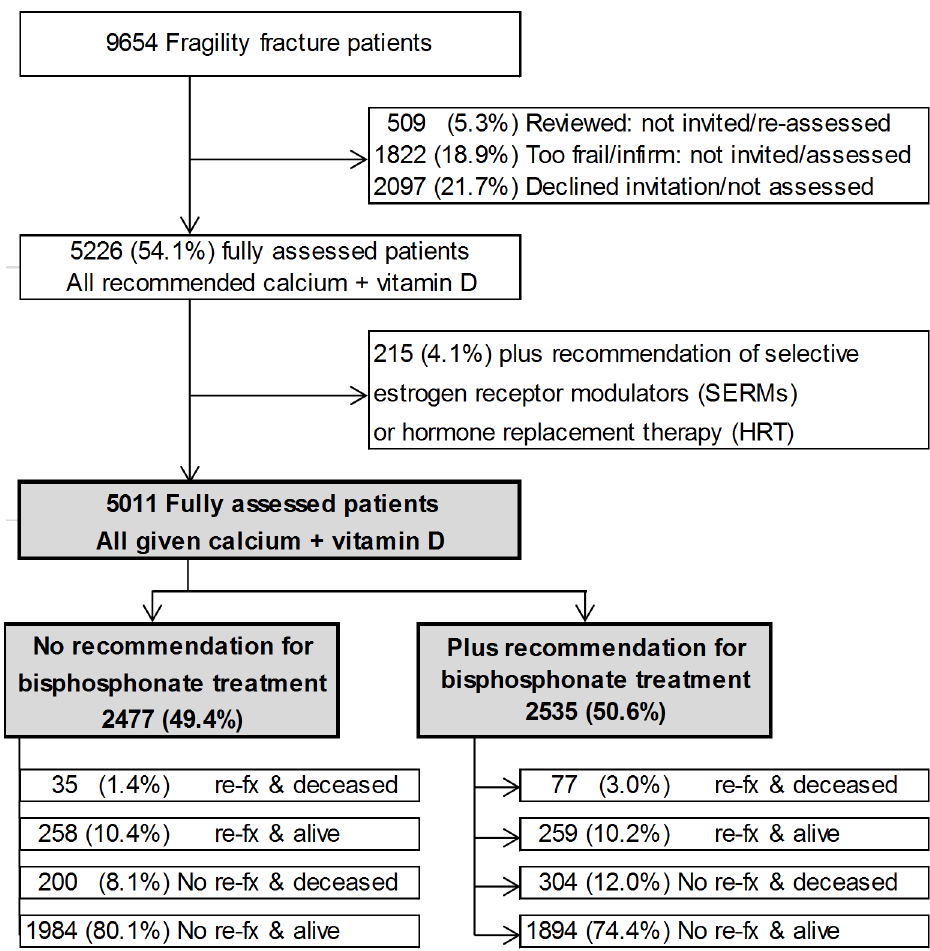
Fig 1. Patient disposition. All patients with low trauma fractures were invited to attend the Fracture Liaison service clinics excluding those already on treatment, considered unsuitable for treatment and/or too frail and elderly and/or declined to attend. The data and analyses herein relate to those who attended and were fully assessed. Re-fx: Subsequent